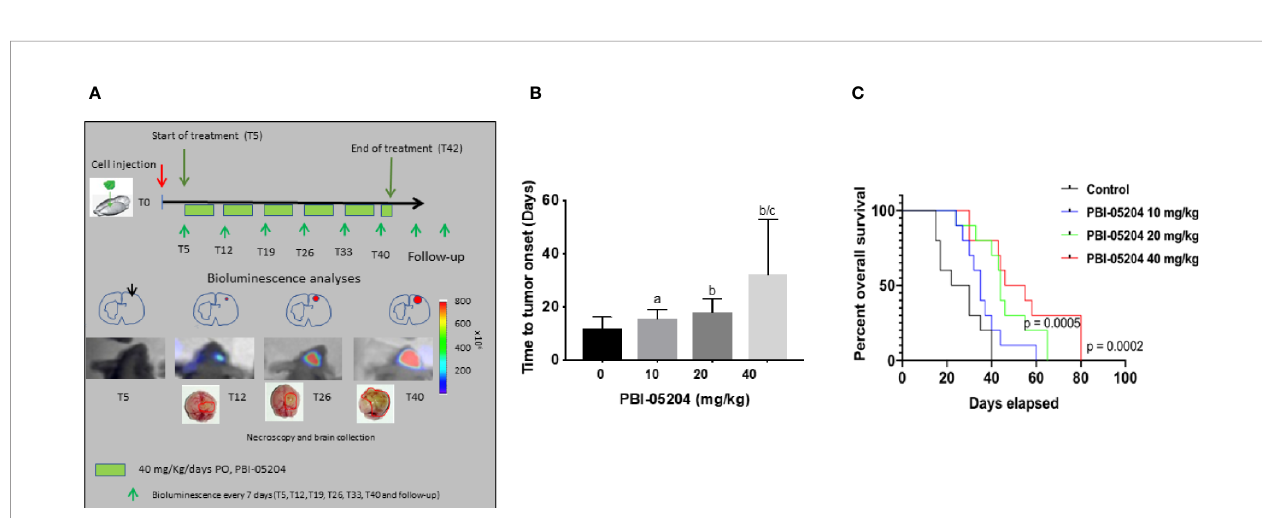
FIGURE 6 | PBI-05204 treatment delayed the onset of tumor and signi fi cantly improved overall survival (OS) in U87MG-Luc cells mouse orthotopic model. (A) Schematic illustration of experiment design of U87MG-Luc orthotopic model treated with PBI-05240. (B) The onset of tumor in mice bearing orthotopic tumor of U87MG-Luc cells. a p < 0.05 versus control. b p < 0.01 versus control. c p < 0.05 versus PBI-05204 (10 mg/kg) – treated group. (C) Overall survival of mice bearing U87MG-Luc cells orthotopic tumor. Data are presented as mean ± SD. N = 10 per